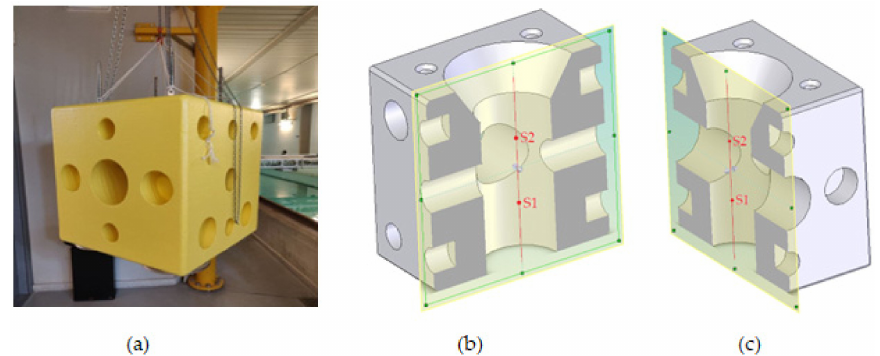
Figure 7. ( a ) AR scale model; ( b ) location of the sensors for orientation A; ( c ) location of the sensors for orientation